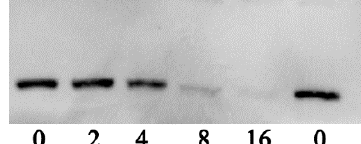
Figure 3. Western blot assay of aerolysin production in supernatants of A. hydrophila co ‐ cultured with indicated concentrations of thymol.